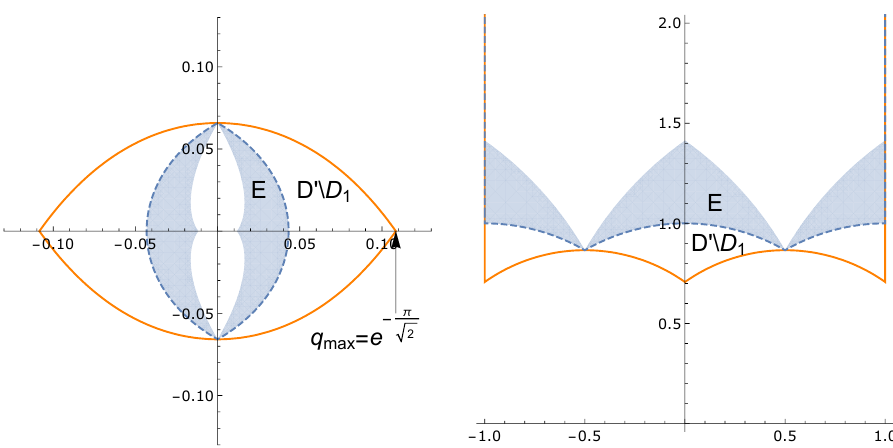
= D 0 E . The left is in the q -plane, and the right in the D n 1 z for the right half and ! (cid:0)